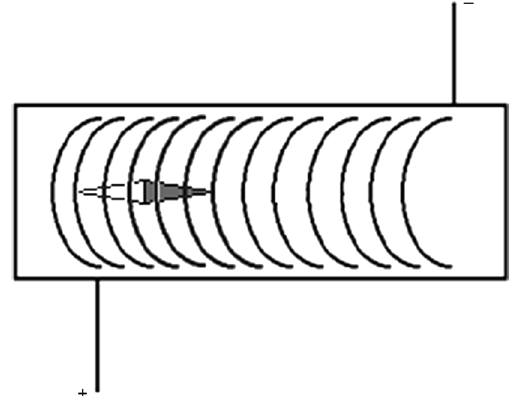
FIG. 2. Experiment 2: demonstrating the direction of magnetic field in various points around a current-carrying coil. A small compass was placed inside a coil and current was then switched on. Students could move the compass inside and around the coil during